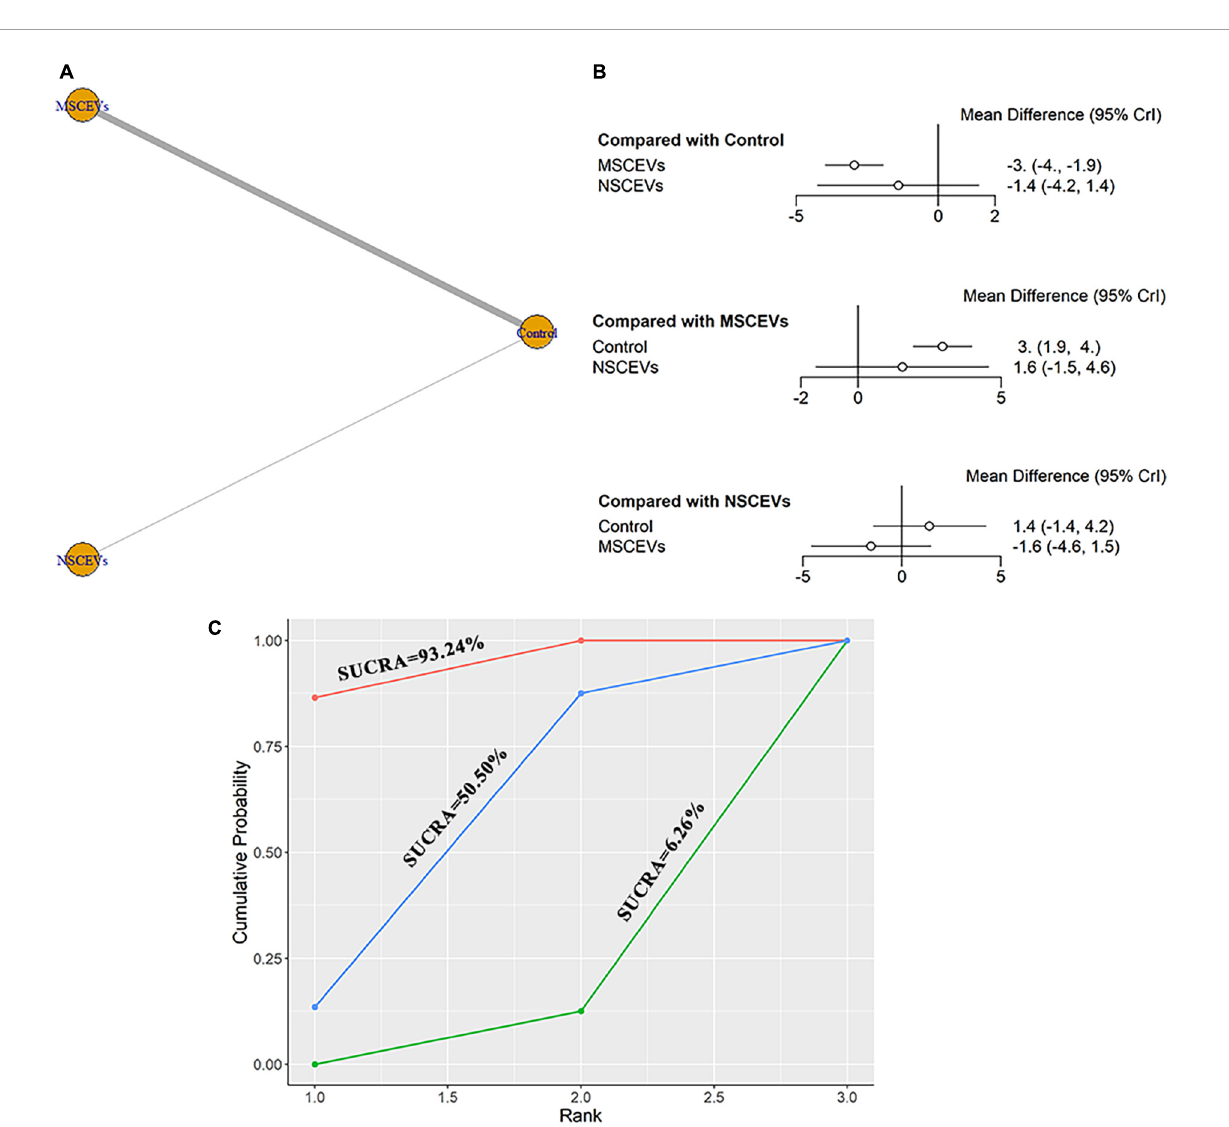
FIGURE7 Comparison of the efficacy of extracellular vesicles (EVs) from different cell sources in modified Neurological Severity Score (mNSS) at day 28 post- traumatic brain injury (TBI). (A) Network plot; (B) Forest plot; (C) Surface under the cumulative ranking curves (SUCRA). AEVs, astrocyte-derived extracellular vesicles; MEVs, microglia-derived extracellular vesicles; MSCEVs, mesenchymal stem cell-derived extracellular vesicles; NSCEVs, neural stem cell-derived extracellular vesicles.